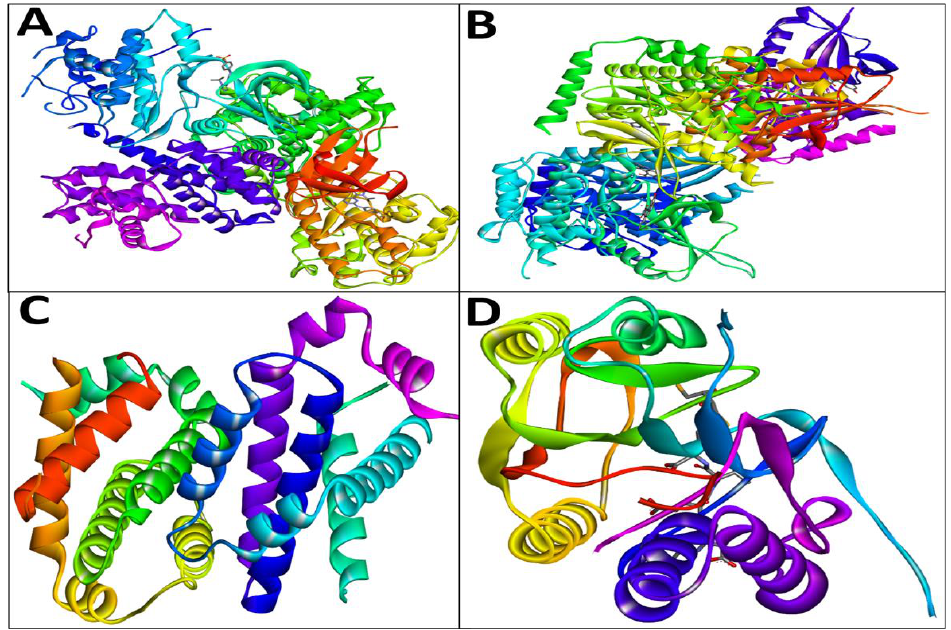
Figure 2. Crystal structure of ( A ) cyclin-dependent kinase 2 (PDB:6GUE), ( B ) TRAF2 and NCK-interacting protein kinase (PDB:2X7F), ( C ) apoptosis regulator Bcl-2 (PDB:4MAN), and ( D ) caspase-3 (PDB:4QU8). 3D graphics were generated using Discovery Studio Visualizer 2021.